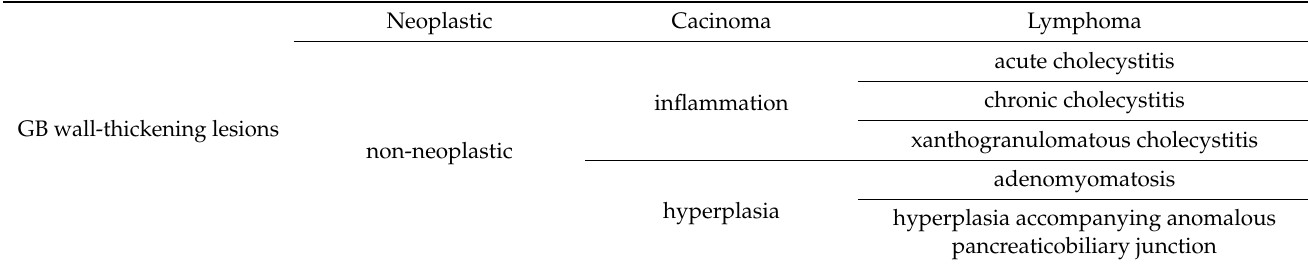
Table 2. Classification of GB wall-thickening lesions.